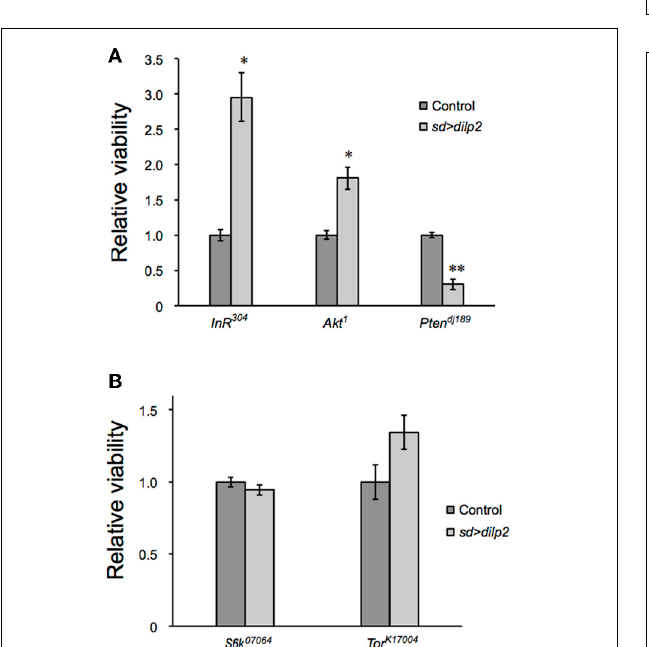
FIGURE 5 | Glucose metabolism in dilp2 -overexpressing flies. Glycolysis (A) and TCA cycle (B) metabolites were analyzed by using LC-MS/MS in negative mode. Relative amounts of metabolites in the sd > dilp2 flies were calculated based on the values of the parental lines ( sd- Gal4 ) and shown as the mean ± S.E of at least three samples with a minimum of five flies per group. G6P: glucose 6-phosphate;F6P: fructose 6-phosphate; F1,6BP: fructose 1,6-bisphosphate; 2/3-PG: 2/3-phophoglycerate; PEP: phosphoenolpyruvate. Student t -test was performed to analyze statistical significance. ∗ p < 0 .